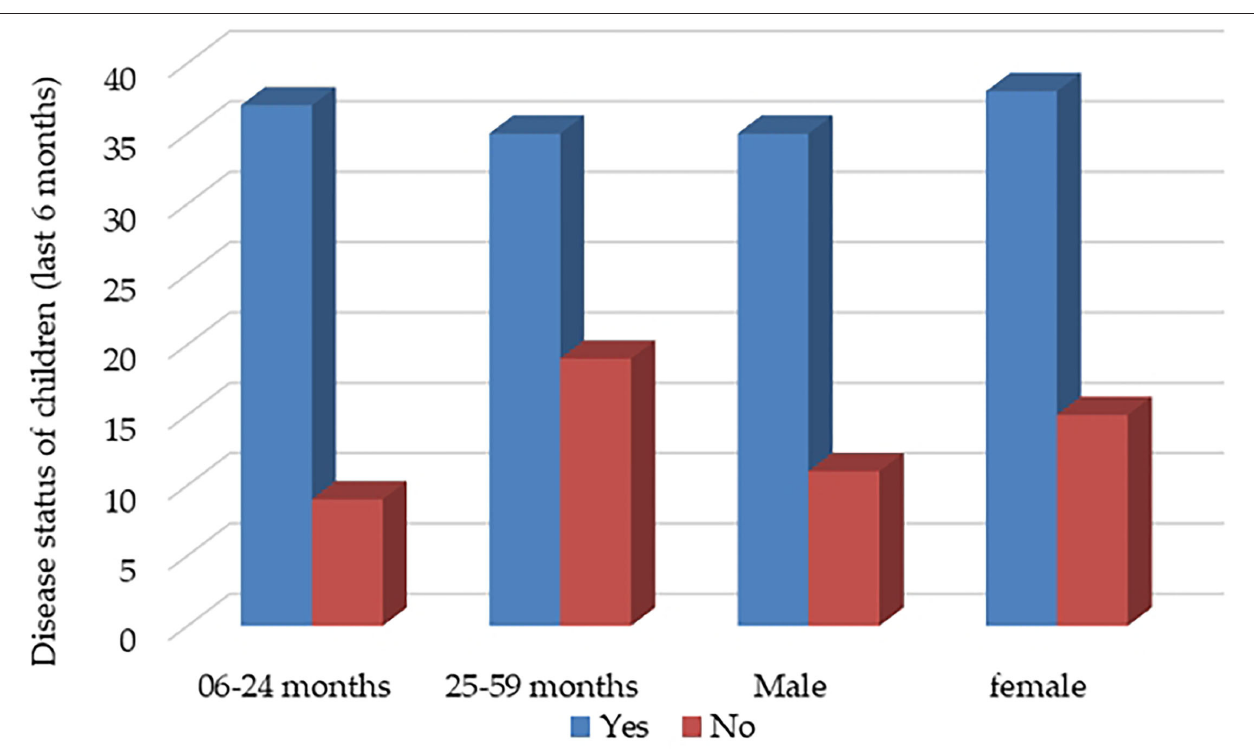
FIGURE 3 | Children’s disease status during the last 6 months.